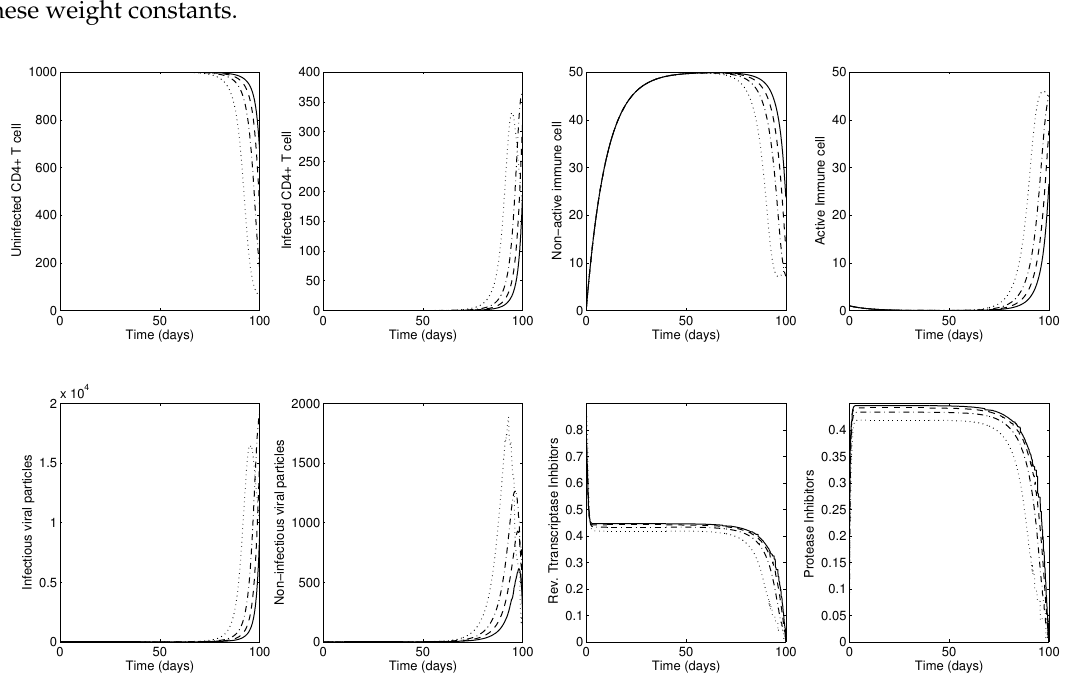
Figure 6. Early-stage dynamics of infection with two controls under four different values of weight constants ( β = 0.000025 and γ = 0.002 are used): A = B = 100,000 (solid), A = B = 50,000 (dashed), A = B = 25,000 (dash-dot) and A = B = 12,500 (dotted). The bottom two right panels show optimal controls for reverse transcriptase inhibitor ( u 1 ) and protease inhibitor ( u 2 ) for 100 days. The two controls RTI and PI should be applied at a medium level during the entire